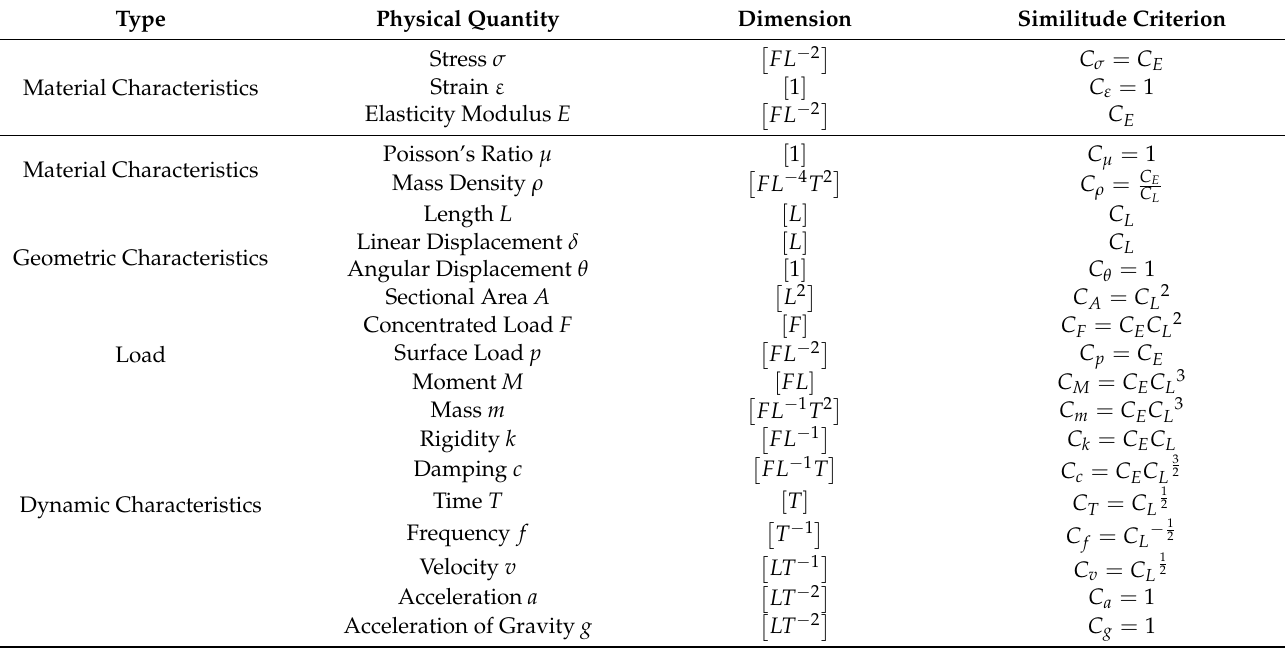
Table 5. Similitude Criteria of the Hydrodynamic Experiment with the Integrated Decommissioning Multi-dimensional Vibration Test